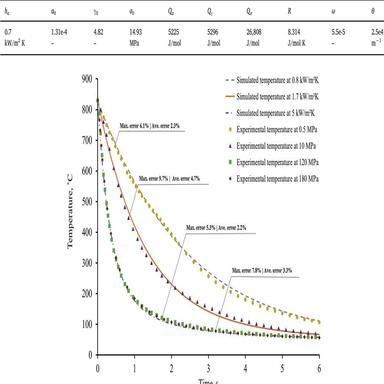
The temperature evolutions of the Ti-6Al-4V at pressures of 0.5, 10, 120 and 180 MPa under dry conditions quenched by the H13 tools.